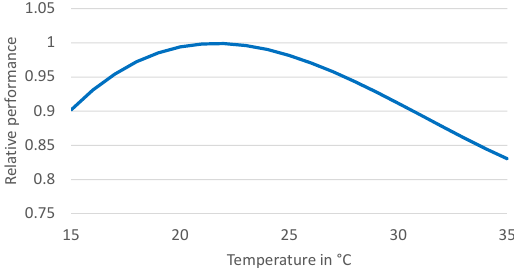
Figure 3. Normalized performance against room air temperature, adapted from